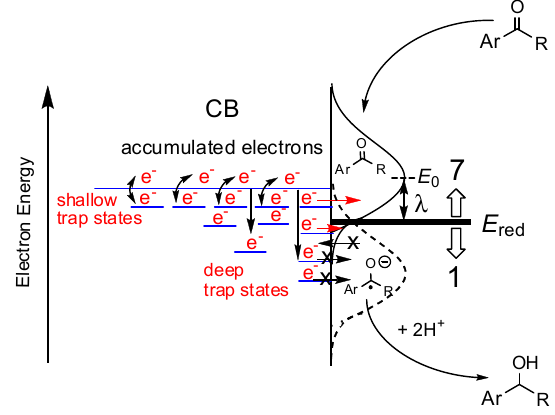
Figure 5. Schematic illustration of the electron transfer reaction from the Ti ds states to the adsorbed AP derivatives, where E red is the reduction potential of AP derivatives, λ is the reorganization energy (approximately 0.7 eV for AP), and E 0 is the energy at the top of curve for the acceptor level, calculated by qE red – λ and shown by the solid line. The dotted line indicates the donor energy level for anionic species. Reprinted with permission from reference [72]. Copyright (2014) The Royal Society of Chemistry.